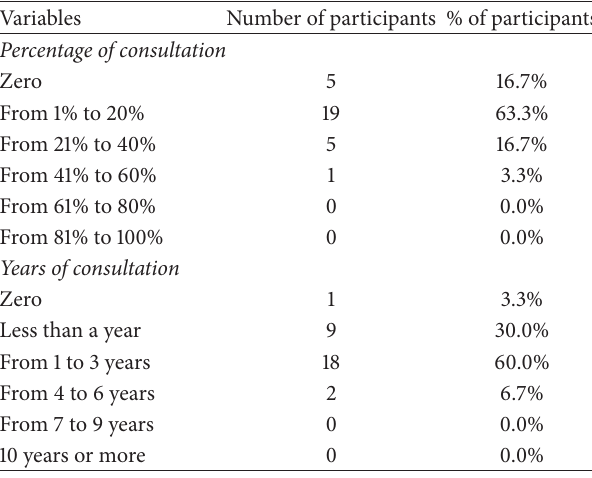
Table 3: Percentage and start/initiation time of consultation.